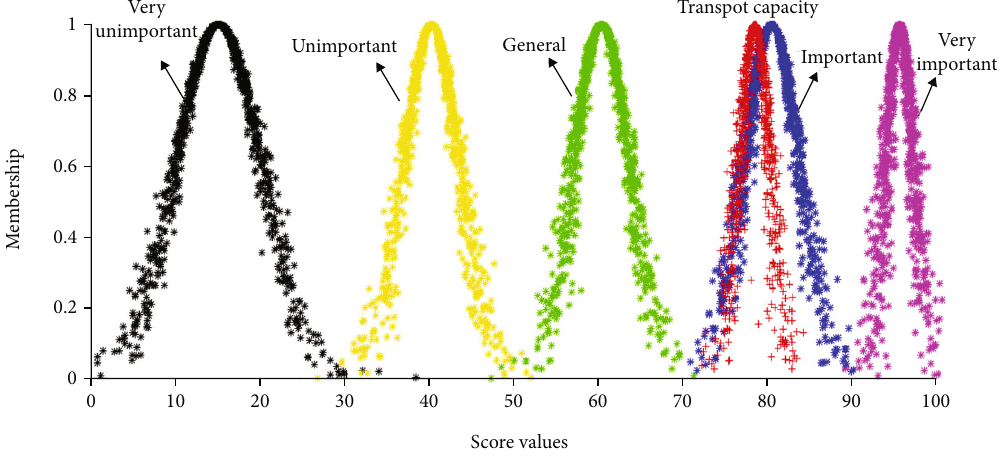
Figure 7: The comprehensive evaluation of transportation